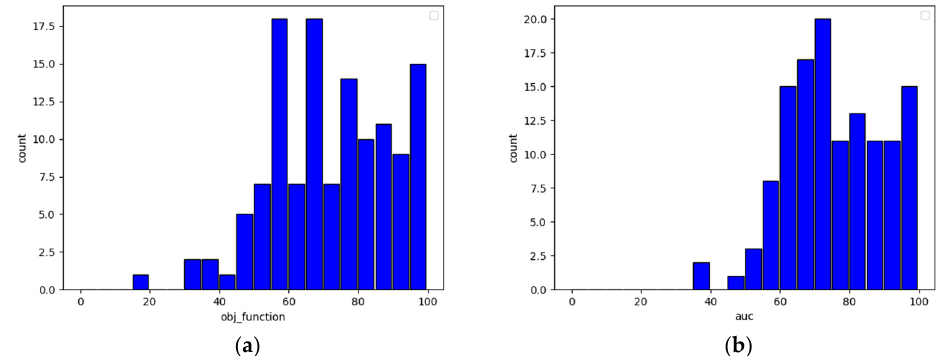
Figure 9. Model quality distribution for all users—objective function ( a ) and ROC-AUC ( b ).